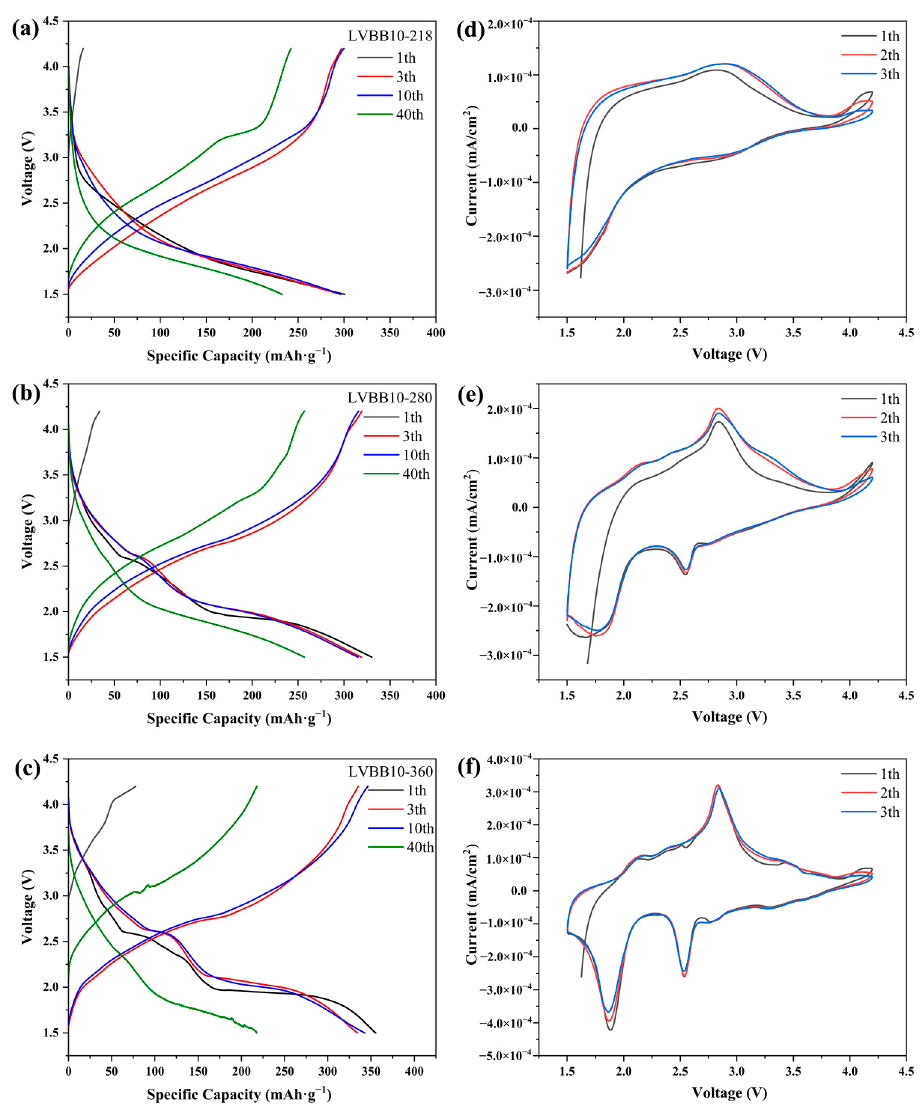
Figure 7. Charge and discharge curves at 50 mA · g − 1 of ( a ) LVBB-218, ( b ) LVBB-280 and ( c ) LVBB-360 in the voltage range of 1.5–4.2 V; CV curves of ( d ) LVBB-218, ( e ) LVBB-280 and ( f ) LVBB-360 in the potential window of 1.5 V–4.2 V with a scanning rate of 0.2 mV · s − 1 . Figures 8a,b show the charge/discharge cycle performance of the LVBB10-218, LVBB10-280, and LVBB10-360 samples at 50 mA·g − 1 and the rate capability at different current densities (at different rates from 50 to 1000 mA·g − 1 ), respectively. The results in Figure 8a show that LVBB10-360 has the highest initial specific capacity of 355.2 mAh·g − 1 compared to the other samples, which is related to the irreversible phase generated in the glass matrix [42]. The irreversible phase (LiV 2 O 5 ) provides additional capacity in the initial few cycles, hence the initial capacity is high, and a clear voltage plateau appears in the discharge curve (see Figure 7c); however, as the intercalation/de-intercalation process of lithium ions proceeds, the crystal structure of LiV 2 O 5 is disrupted, the discharge voltage plateau gradually disappears (see Figure 7c), and the capacity also decreases rapidly in the first three cycles. The discharge capacity of LVBB10-360 decays too fast, indicating its poor charge/discharge cycle stability, which is due to the higher crystallinity of LVBB10- 360 compared to LVBB10, LVBB10-218 and LVBB10-280. The higher crystallinity means that LVBB10-360 is not as structurally loose as the other samples and is more affected by